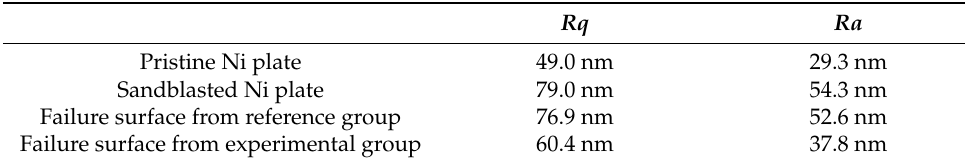
Figure 12. AFM images of the Ni plate ( a ) without and ( b ) with sandblasting and the failure surface of the joints from ( c ) experimental and ( d ) reference groups after the tensile test. Table 6. Measured data of the surface roughness explored via AFM.